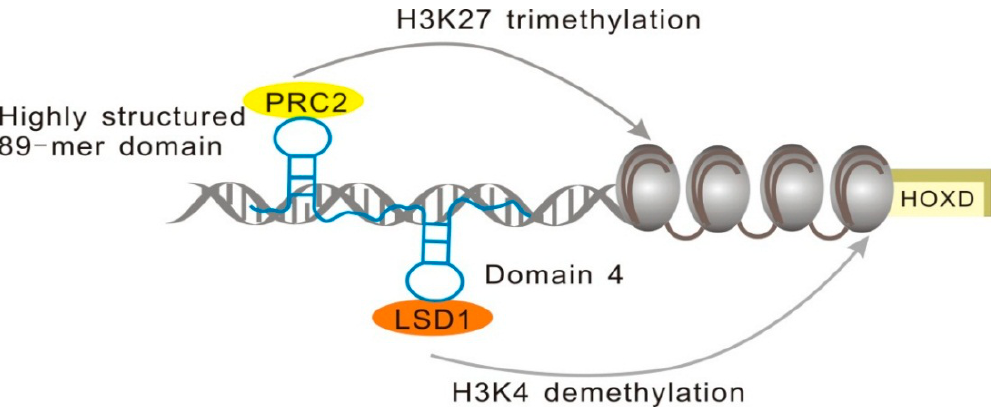
Figure 4. minHOTAIR and D4 regions of HOTAIR recruit PRC2 and LSD1, respectively, in order to regulate HOXD expression.